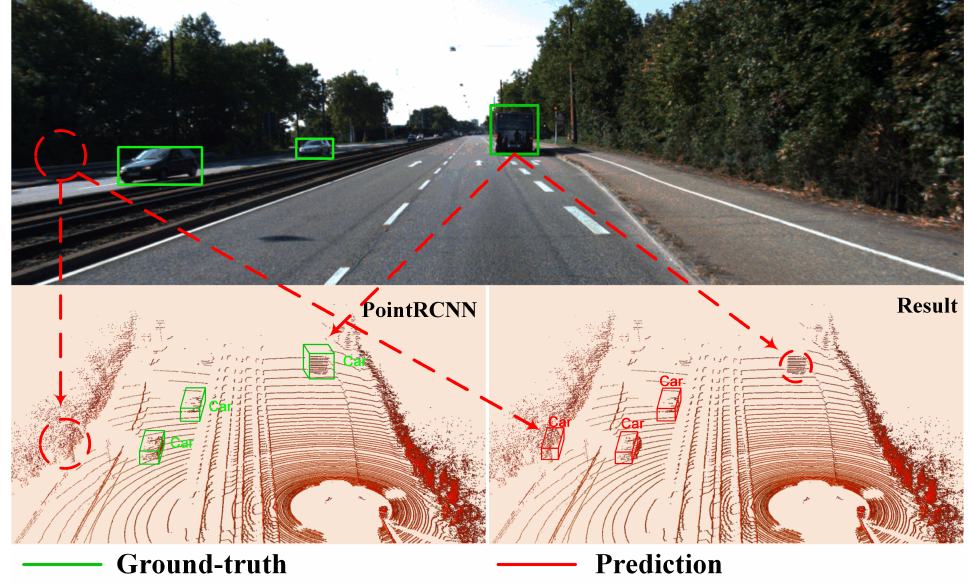
Figure 1. Vehicle detection results. The first row shows the corresponding 2D image. The second row is the ground truth and the detection results from PointRCNN. We highlight missed and false detections in the dot column with red